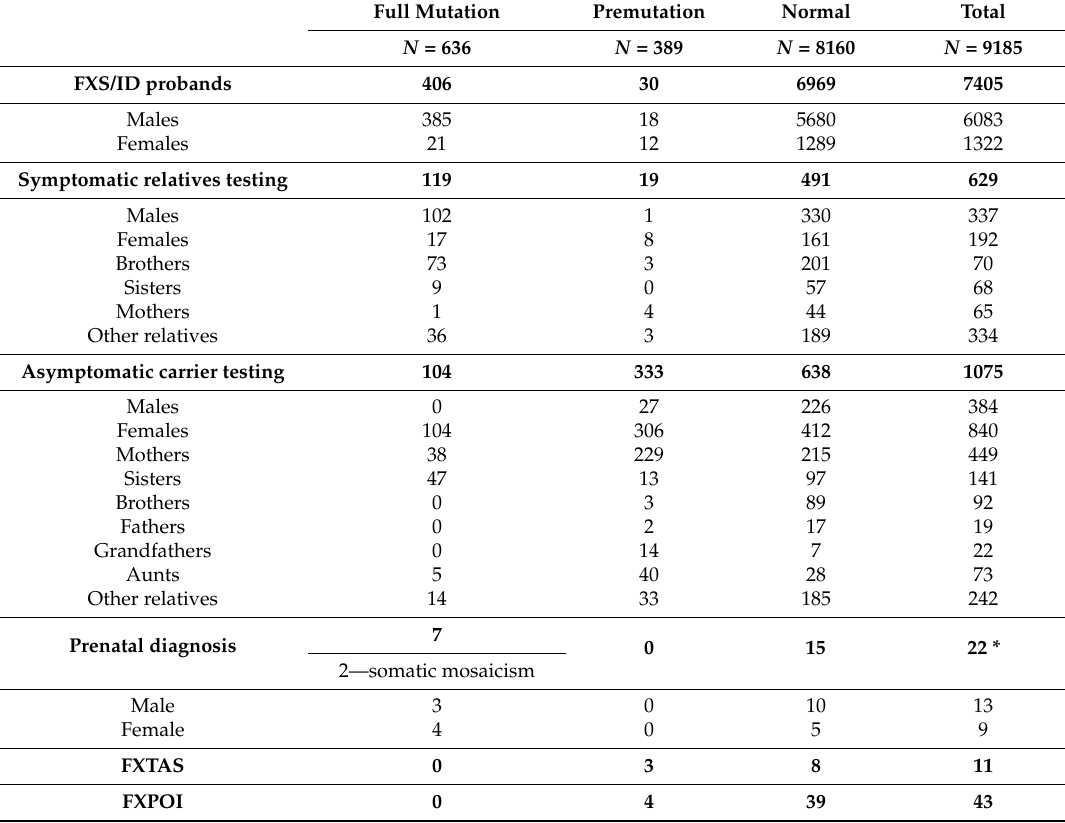
Table 1. Summary of the results of molecular diagnosis of the FXS in the Polish